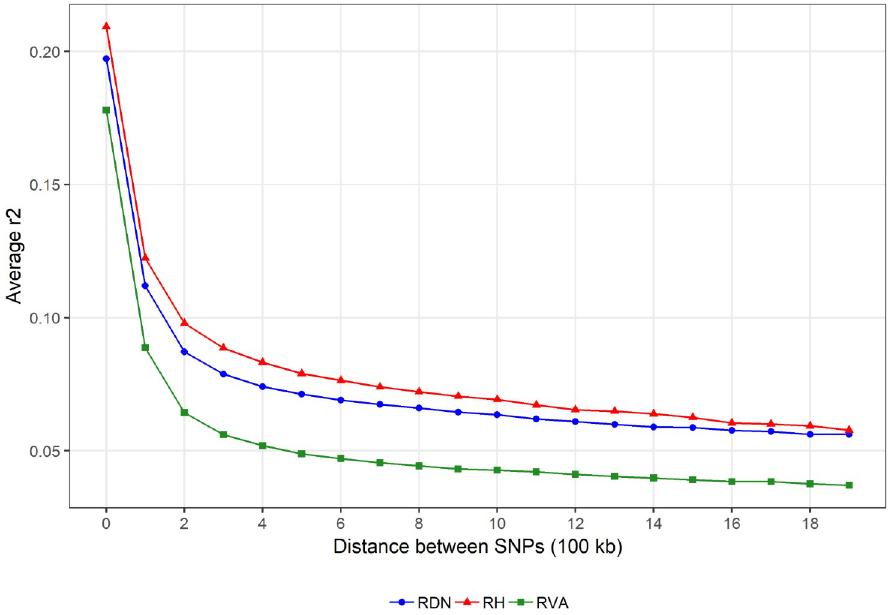
Fig 1. Average linkage disequilibrium (LD) decay in Angler (RVA), Red-and-White dual-purpose (RDN) and Red Holstein (RH). segments ( > 30 Mb) were very few (~5%) but the proportion was even smaller for length class 1 to 5 Mb. Regardless of the minimum length of ROH threshold or method of computation, inbreed- ing was generally lower in RVA, intermediate in RDN and highest in RH (Table 4). When the minimum length of ROH was set to 4 Mb, average F varied from 2.1% (RVA) to 5.3% ROH (RH). The estimates varied from 1.8% to 4.4% and 0.9% to 2.3% for minimum length setting of 8 and 16 Mb, respectively. F within breed also varied (see standard deviations) with values ROH reaching over 11% in some RDN and RH individuals. Overall, F decreased with increased ROH minimum ROH length threshold. Negative values were obtained for F in most individuals. HOM Estimation of F was only possible for RVA and RDN since pedigree records were not avail- PED able for the RH genotypes. The completeness of pedigree in RVA and RDN are provided in S1 Fig. The pedigree-based average inbreeding coefficients estimated were generally lower than those computed from ROH. In Fig 4, the linear regression plots of F on F (left) and ROH PED F on F (right) for RVA and RDN are provided for the different ROH length thresholds ROH HOM (A, B and C). Within and across breeds, moderate to high correlations significantly different from 0 (p-value < 2.2e-16) were found for all comparisons. Between F and F was ROH PED, r p strongest for the 4 Mb threshold (0.701, R 2 = 0.491), followed by 8 Mb (0.690, R 2 = 0.476) and then 16 Mb (0.620, R 2 = 0.385). The correlations between the two genomic inbreeding mea- sures (i.e. F vs. F ) were slightly stronger and followed the afore-mentioned pattern, ROH HOM thus 4 Mb (0.752, R 2 = 0.565), followed by 8 Mb (0.740, R 2 = 0.548) and then 16 Mb (0.660, R 2 = 0.435). An investigation of the relationship between F and F showed a compara- HOM PED tively weaker correlation (0.511, R 2 = 0.261) between the two inbreeding measures, although significant at p-value = 5.246e-16 (S2 Fig). The intercept of the regression of F on F was ROH PED high (0.011) at the minimum ROH length threshold of 4 Mb and close to 0 (0.002) when the minimum length was increased to 16 Mb.